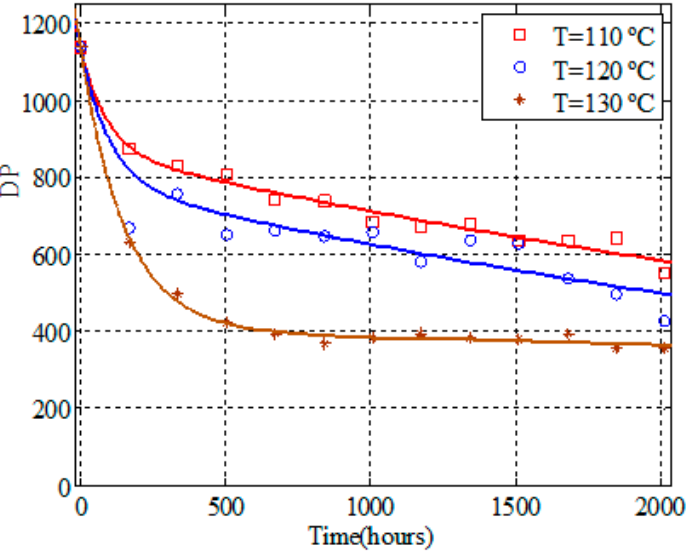
Figure 4. Ageing process of natural-ester immersed paper as a function of temperature. The complete study is reported in [7]. Reprint with permission [7], Copyright 2017, IEEE.